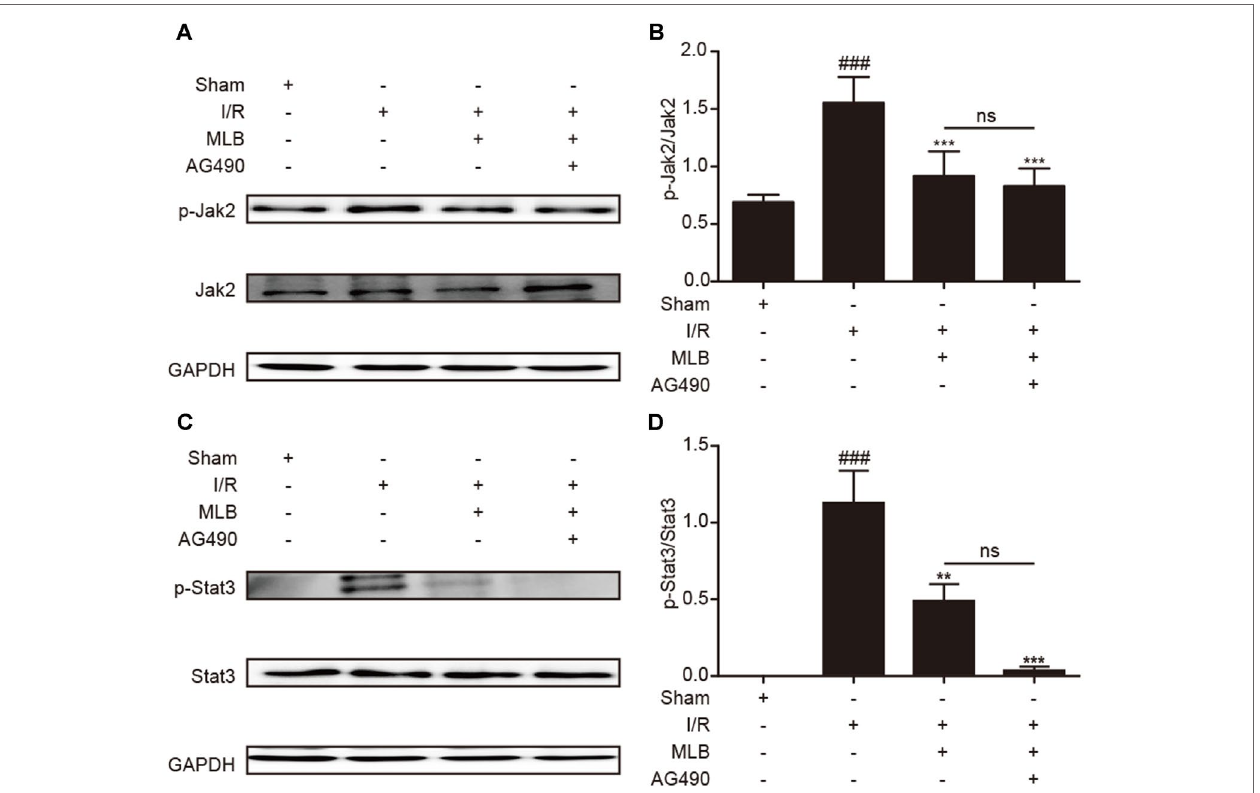
FIGURE 7 | MLB+AG490 pretreatment inhibited Jak2/Stat3 signal pathway in the liver tissue of I/R. (A) Western blot was utilized to detect the level of p-Jak2. (B) The quantification of p-Jak2/Jak2 was statistically analyzed. (C) Western blot was utilized to detect the level of p-Stat3; (D) The quantification of p-Stat3/Stat3 was statistically analyzed. The data are expressed as mean ± SD; n = 5 for each group; ns: no statistical significance; ### P < 0.001 versus sham group; **P < 0.01, and ***P < 0.001 versus I/R